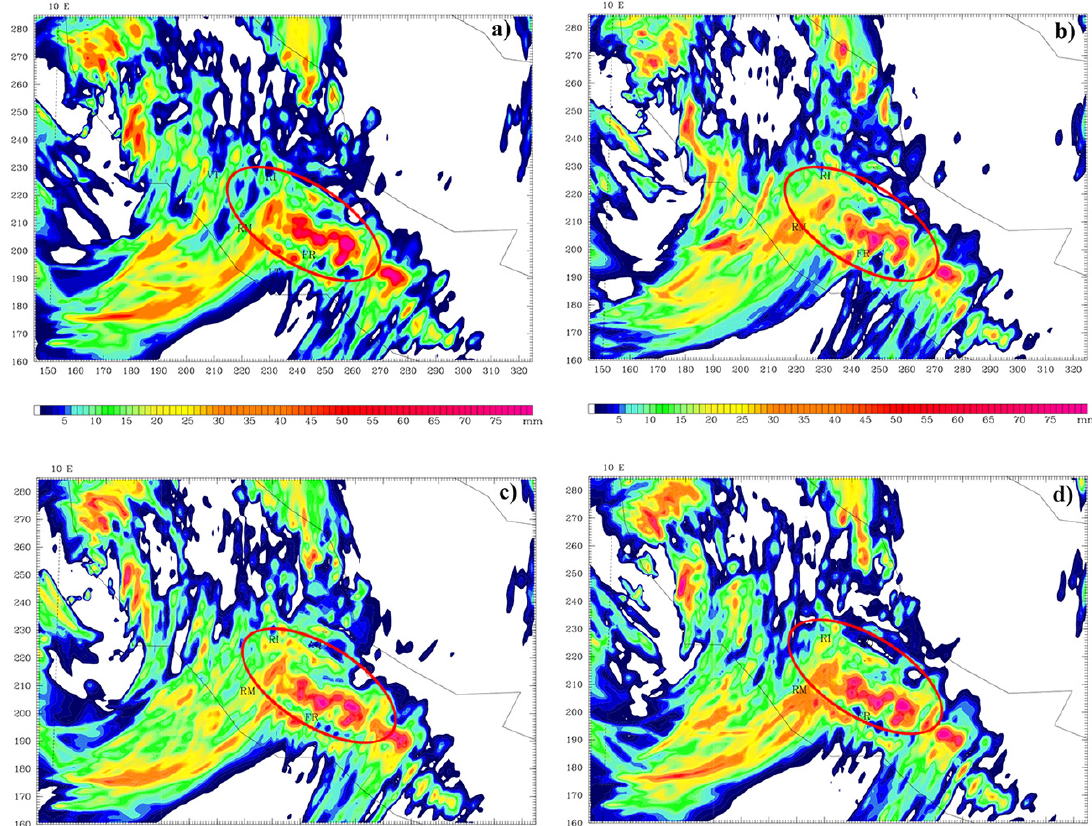
Figure 10. 12h accumulated rainfall ending at 22:00UTC on 20 May 2008 estimated by WRF experiments: (a) CTL, (b) CON, (c) RAD and (d)